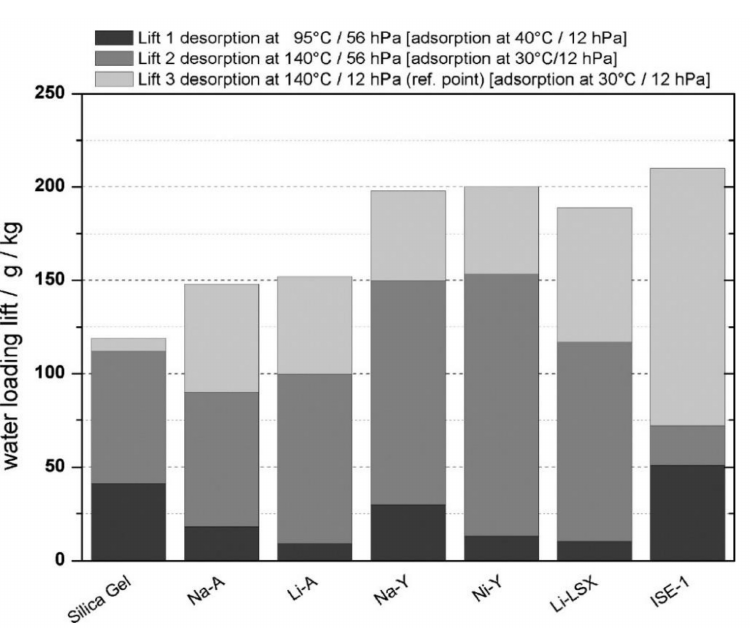
Figure 8. Water loading spread for different adsorbents